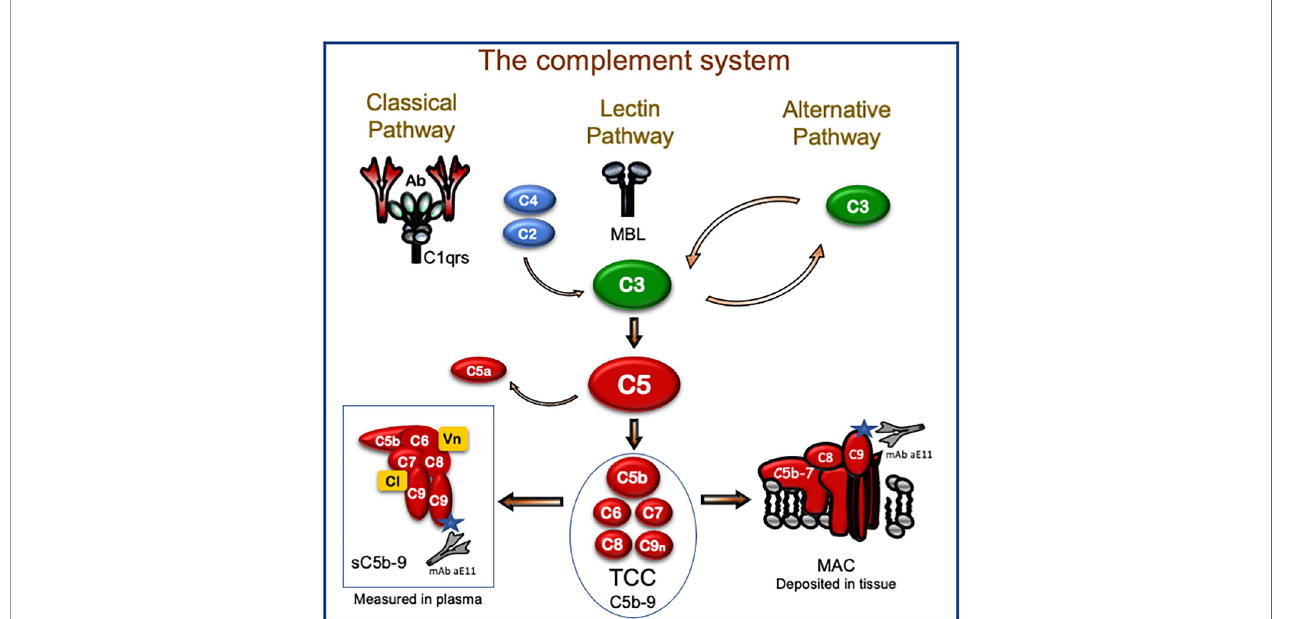
FIGURE 1 | The complement system with focus on the terminal C5b-9 complement complex (TCC). Initial activation occurs through the classical, lectin, and alternative pathways that all converge on C3 that further activate C5 by cleavage into the potent proin fl ammatory fragment C5a and C5b. The latter initiates the formation of the TCC. TCC is a macromolecule composed of C5b, C6, C7, C8, and a couple of C9 molecules. If this assembly occurs at a surface of a lipid membrane like a microbe or cell, the macromolecule gets amphiphilic after C7 assembly and attaches to the lipid membrane. This is followed by binding of C8 and C9 within the membrane, and the complete assembly product (C5b-9) penetrates the lipid membrane and may lead to lysis. This form of TCC is frequently termed membrane attack complex (MAC) and is a pure physiochemical penetration of a lipid membrane based on molecular changes (lower right). If TCC assembles in the fl uid phase (lower left), like in plasma with no lipid membrane close to the activation, a fl uid-phase analog is formed. Two regulatory proteins (Vn, vitronectin; Cl, clusterin; marked yellow in the box bottom left) are necessary to cover the lipophilic sites of this macromolecule, also termed soluble TCC (sC5b-9). TCC can be detected in plasma and other body fl uids and is the most frequently used complement activation product to evaluate the degree of complement activation in vivo . This complex is detected in ELISA, taking advantage of a monoclonal antibody (aE11) highly speci fi c for a neoepitope exposed in C9 only when C9 is incorporated in TCC (both sC5b-9 and MAC, see bottom left and right). Thus, MAC, which is an important pathogenic factor of complement activation, inducing both in fl ammation and lysis, can be detected in the tissue by immunohistochemistry using the C9 neoepitope-speci fi c antibody, whereas the TCC, which is inert and harmless, in contrast to MAC, can be detected by the same antibody in plasma using ELISA. Most importantly, TCC is a surrogate marker for C5a, which is a highly pathogenic mediator. C5a is, however, more dif fi cult to detect in vivo , since it binds to the C5a receptors and has a very short half-life of 1 min, whereas TCC has a half-life of 1 h and is a very stable activation product also in vitro